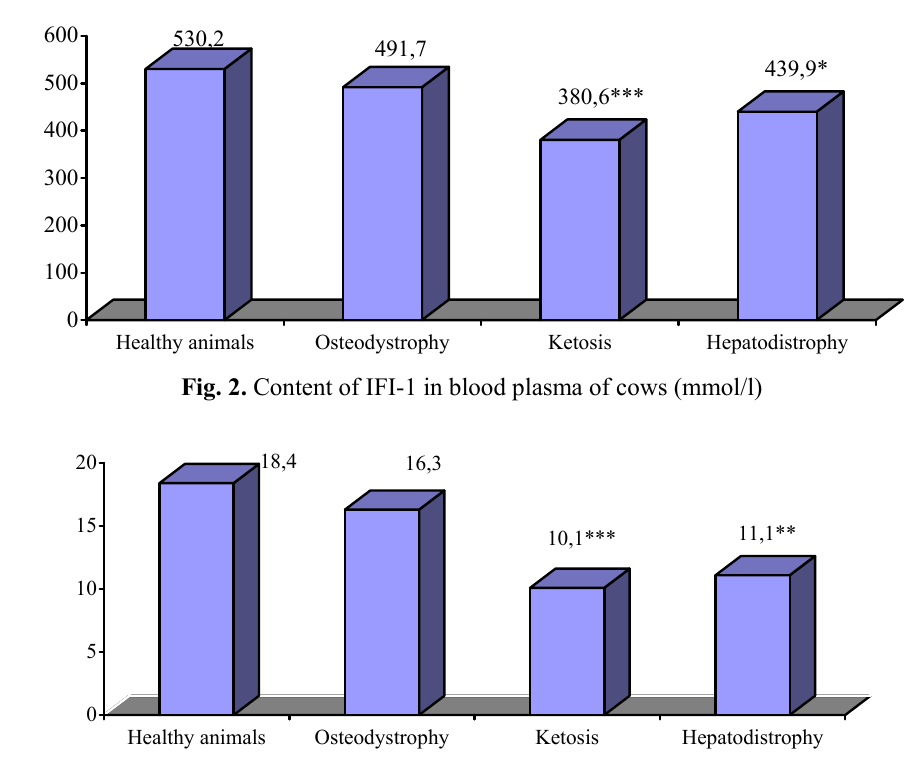
Fig. 3. The content of leptin inblood plasma of studied cows